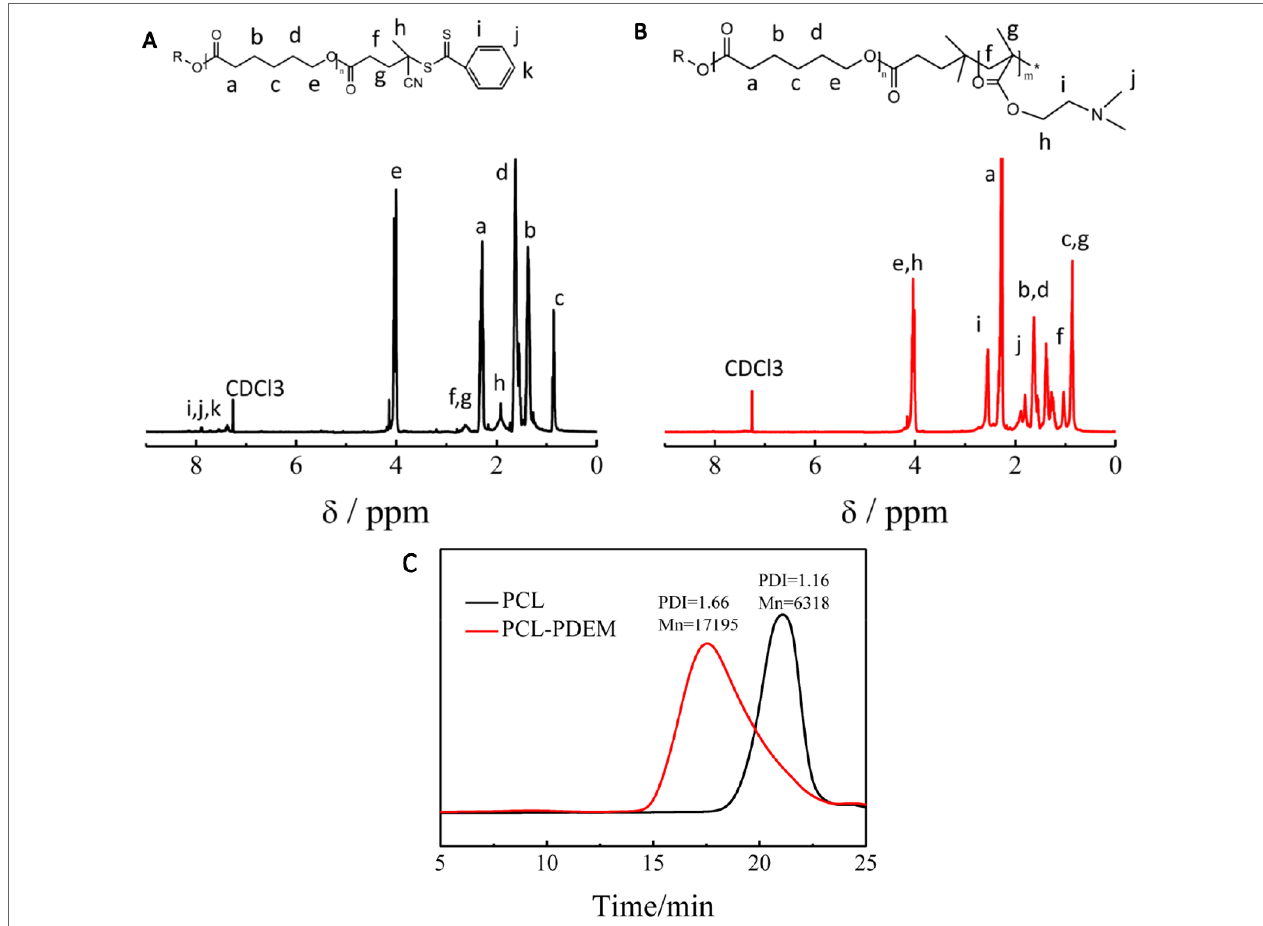
FIGURE 1 | The characterization of PCL and PCL-PDEM. (A) 1 H NMR of PCL-CAPD, (B) 1 H NMR of PCL-PDEM, and (C) GPC of PCL and